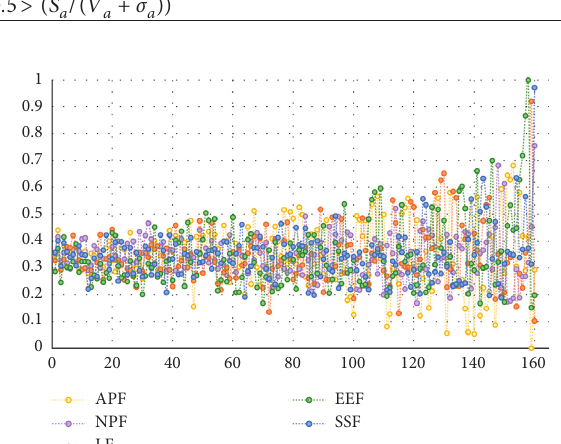
Figure 4: Index value of rural multifunction in Jingjiang city in